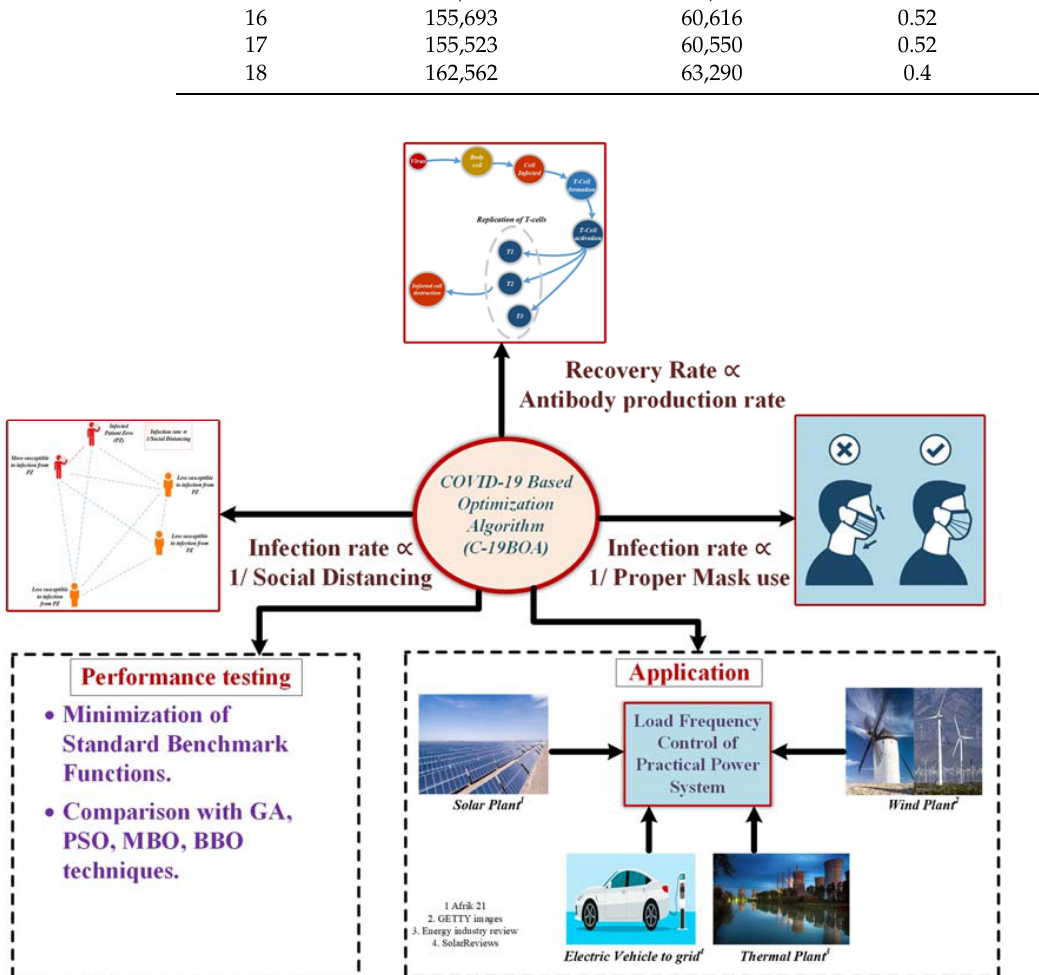
Figure 10. Novel Optimization Approach based on COVID-19. The performance of this novel optimization approach is compared with five other optimization approaches: GA, Biogeography-based optimization (BBO), PSO, Arithmetic Optimization Algorithm (AOA), and Magnetotactic bacteria optimization (MBO). For